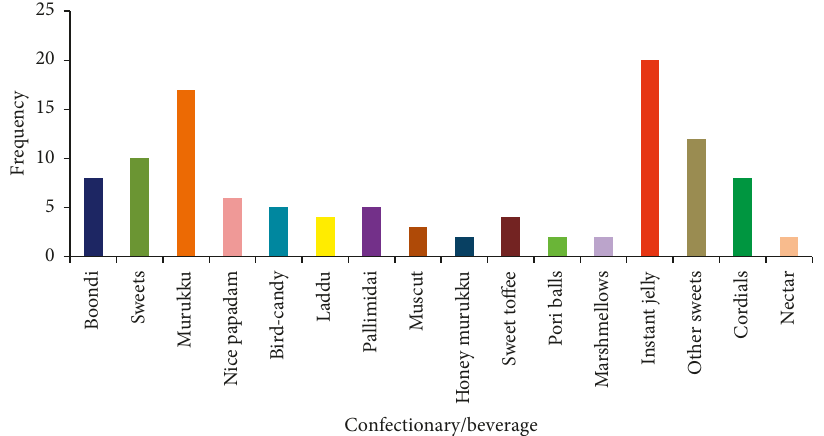
Figure 1: Frequency of different categories of confectioneries and beverages collected in Jaffna district.